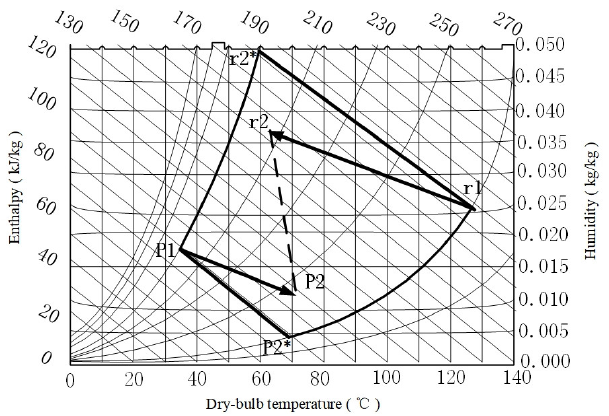
Figure 12. The state of the air in and out of the rotor on the enthalpy-moisture diagram.